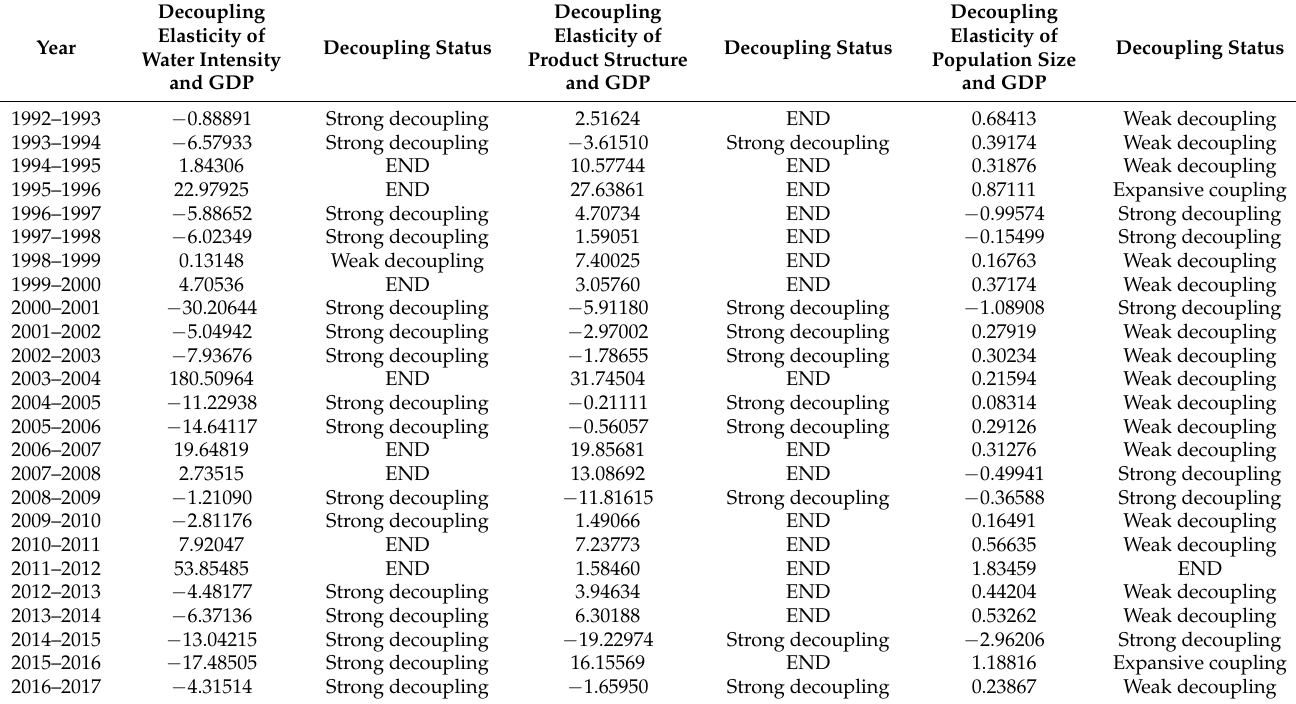
Table 6. Decoupling status of the driving factors of virtual water trade (VWT) and economic growth